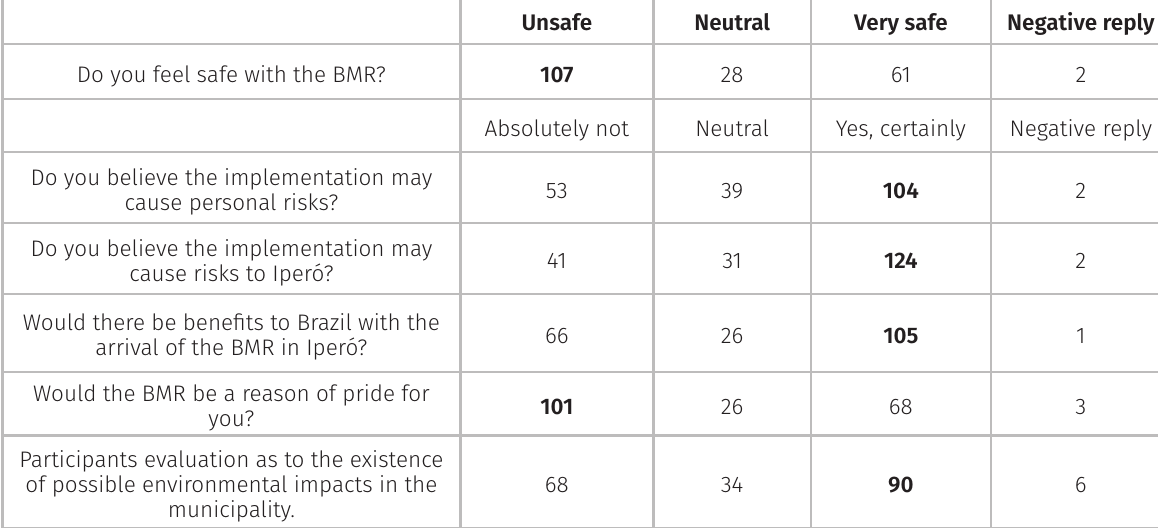
Table I. Participant’s responses regarding issues related to personal risk, collective risk and environmental risk related to the implementation of BMR in the municipality (N =